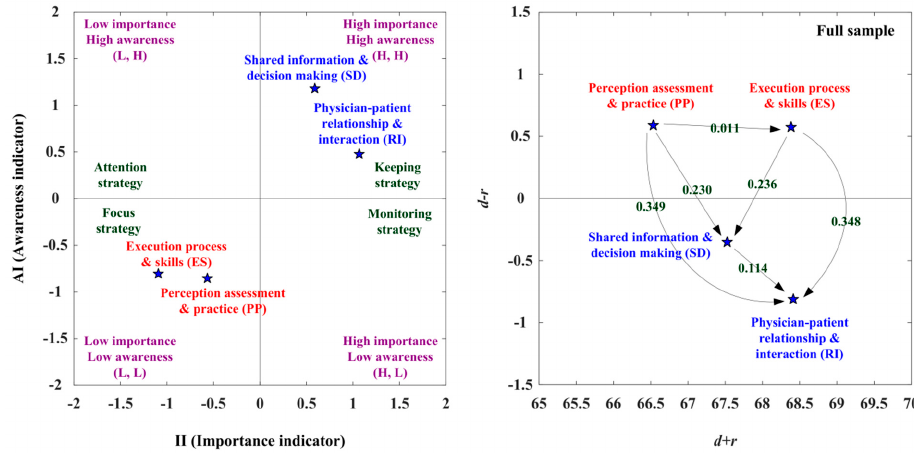
Figure 2. The IAA-NRM map of SDM competency development. Table 3. The adoption strategy of SDM competency development.